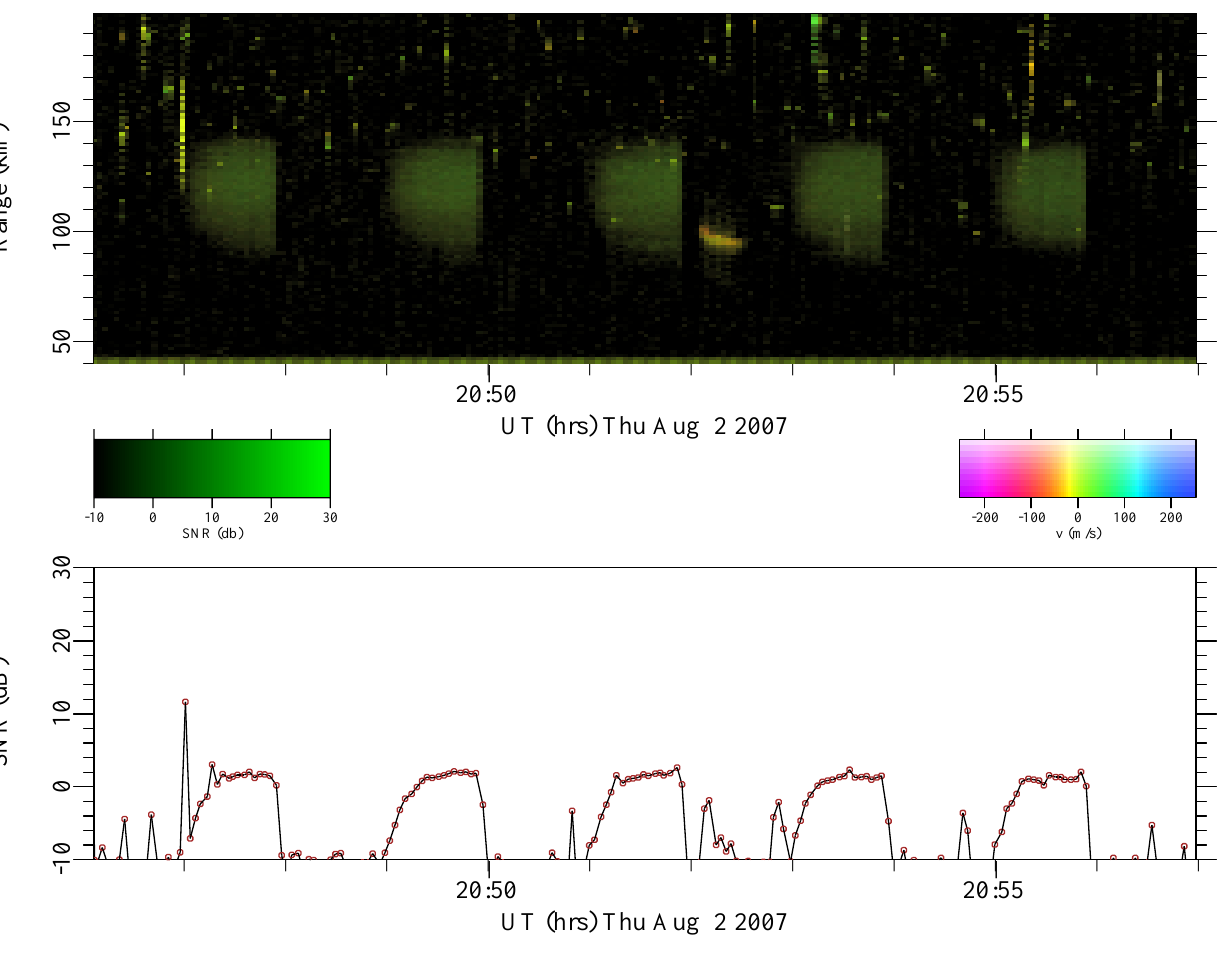
Fig. 8. RTDI plot for 2 August 2007. The lower panel shows the signal-to-noise ratio for echoes between 110–130 km.